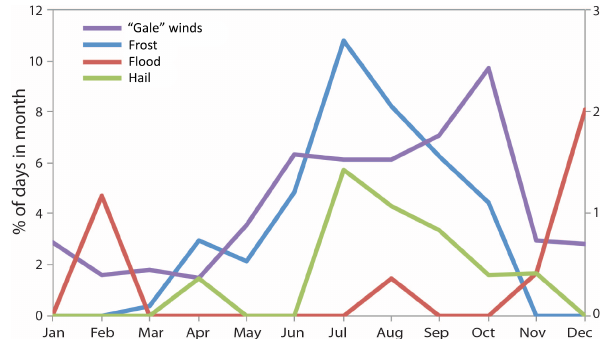
Figure 5. Climatology of qualitative observation for “dirty weather” rain days and “dry” days (left-hand scale) vs. “dirty weather” and cloud (right-hand scale) percentage of days per month in the Reverend Davis’ meteorological diary.